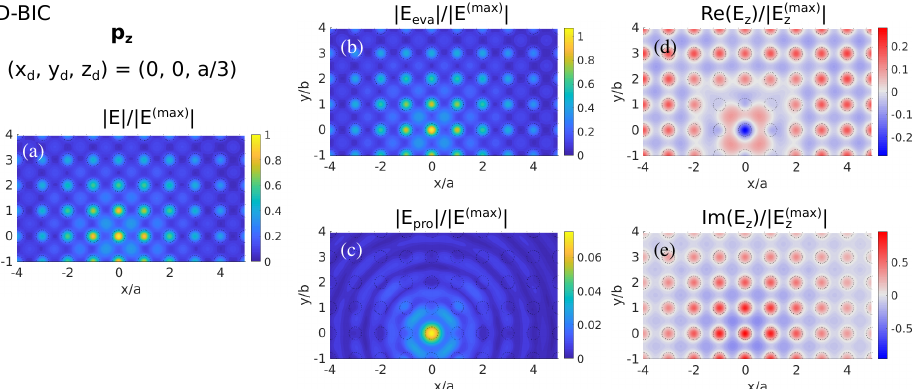
Figure 4. Color maps of the normalized electric near-field on a plane at z = a /3 ≈ 133 nm scattered from a Si nanosphere metasurface as in Figure 1, when illuminated by a vertical point ED source at the wavelength of the symmetry-protected ED-BIC ( λ = 552 nm) located at ( x d , y d , z d ) = ( 0,0, a /3 ) ; thus, z d = z ≈ 133 nm. ( a ) Total electric field amplitude, showing separately the contributions from the ( b ) evanescent and ( c ) propagating components, and the real ( d ) and imaginary ( e ) parts of the vertical electric field